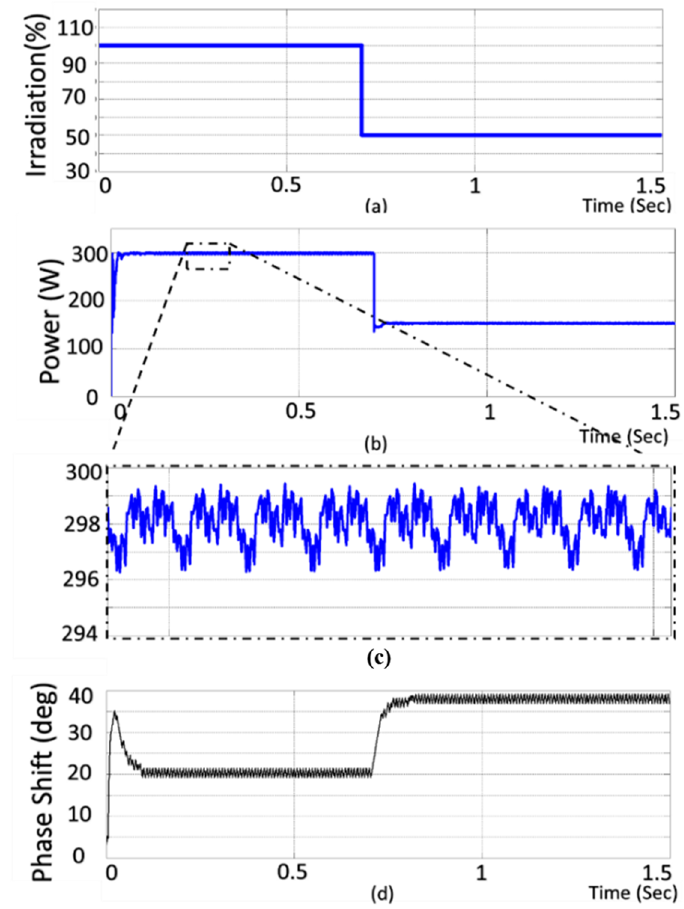
Figure 7. Proposed fixed-step FFPS predictive MPPT control: ( a )the irradiation profile ( b ) the PV input power and the maximum power ( c ) the power oscillation ( d ) the phase-shift change.